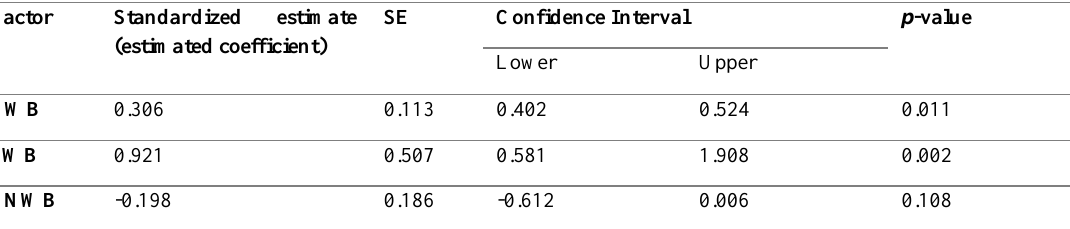
Table 5 : Standardized Estimated Result of Three Pillar Well-Being Dimensions of Sustainability to Overall Well-Being